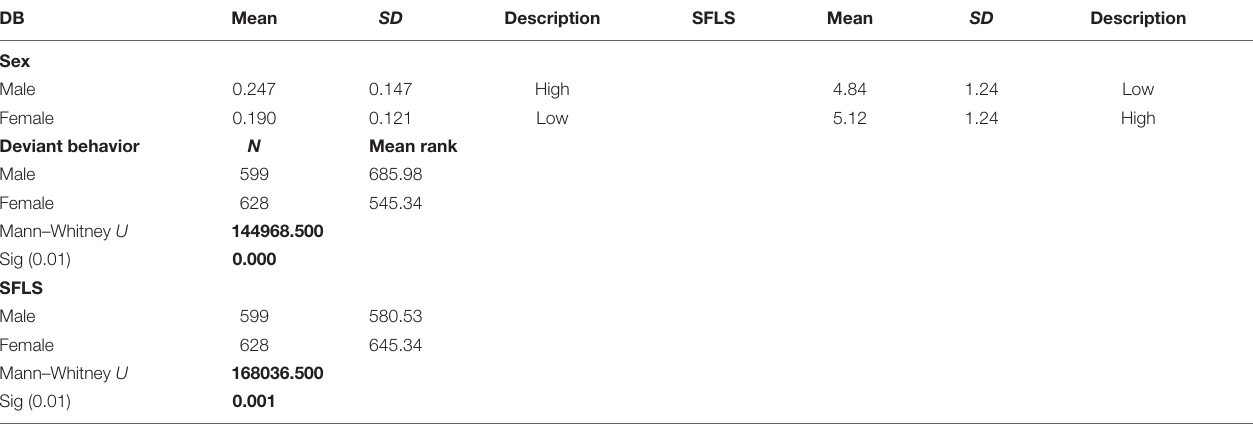
TABLE 3 | Mean of the deviant behavior and the family satisfaction in terms of sex.